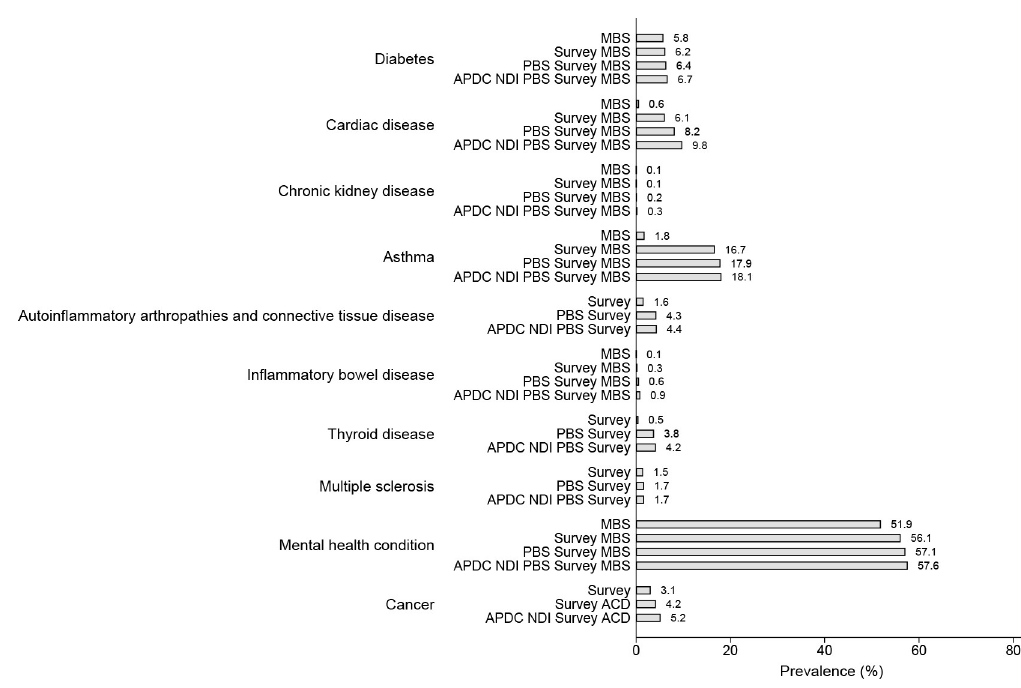
disease, cancer and chronic kidney disease benefitted from the addition of all available data sources with the prevalence incrementally increasing with the addition of each data source.